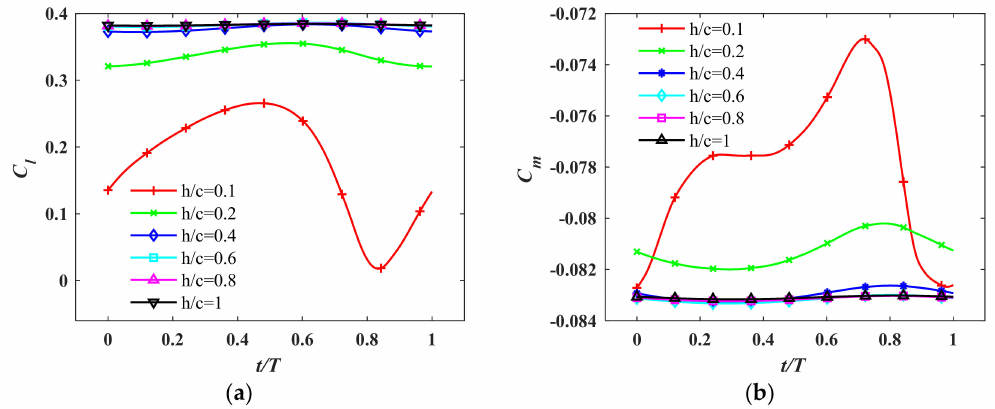
Figure 12. The change in the aerodynamics of di ff erent ride heights at α = 0 ◦ : ( a ) lift coe ffi cient, ( b ) moment coe ffi